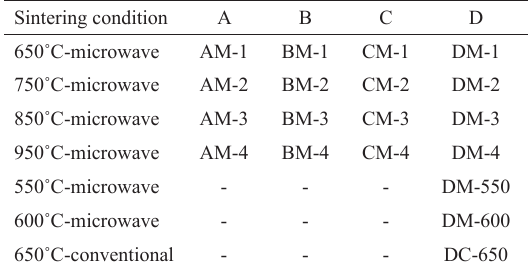
Table 2: Sample coding after sintering.